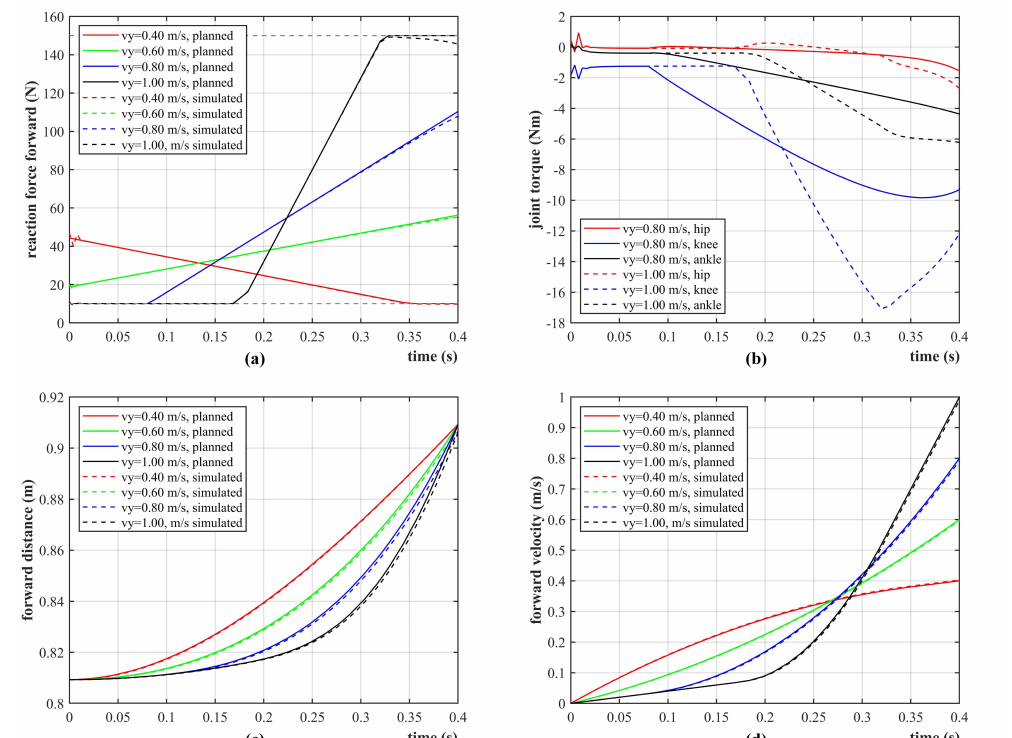
Figure 8. Motion planning and control of the PFP locomotion targeted at various forward free-flying velocities. ( a ) reaction forces in the forward direction. ( b ) joint torques. ( c ) COM positions in the forward direction. ( d ) forward